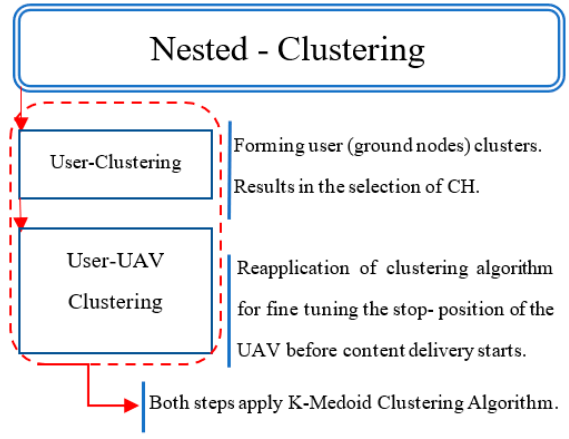
Figure 3. The nested clustering concept.